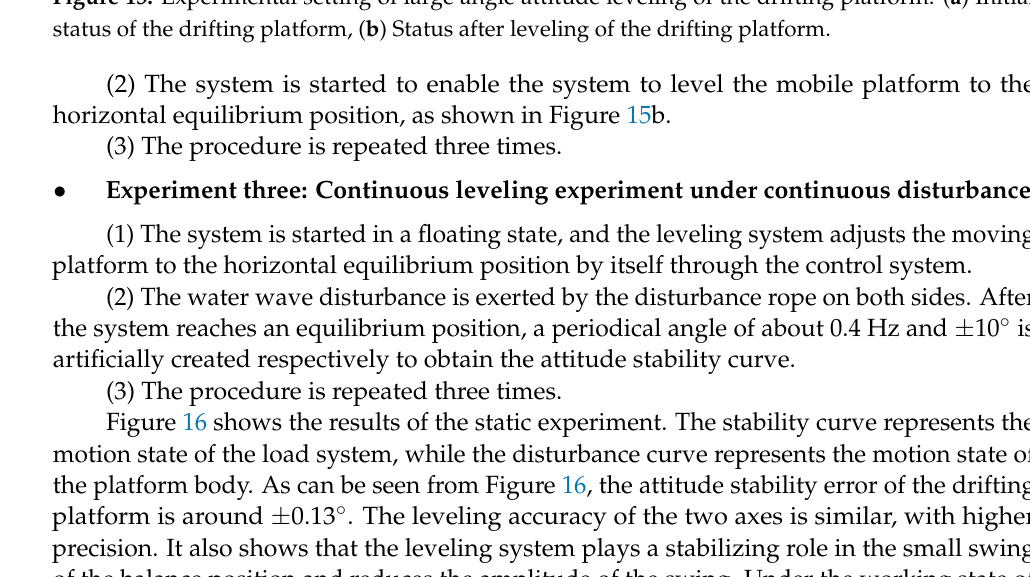
Figure 15. Experimental setting of large angle attitude leveling of the drifting platform. ( a ) Initial status of the drifting platform, ( b ) Status after leveling of the drifting